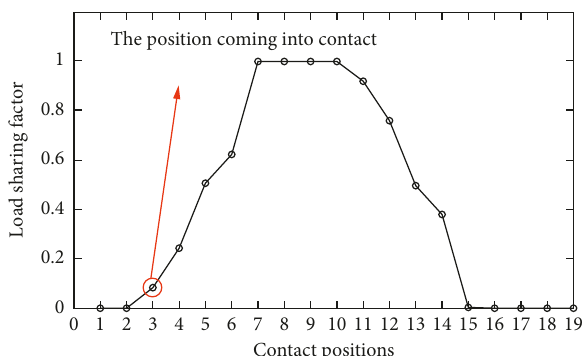
Figure 8: Approximate location of original meshing point (the contact positions on the curve appear in the process from meshing- in to meshing-out for a single